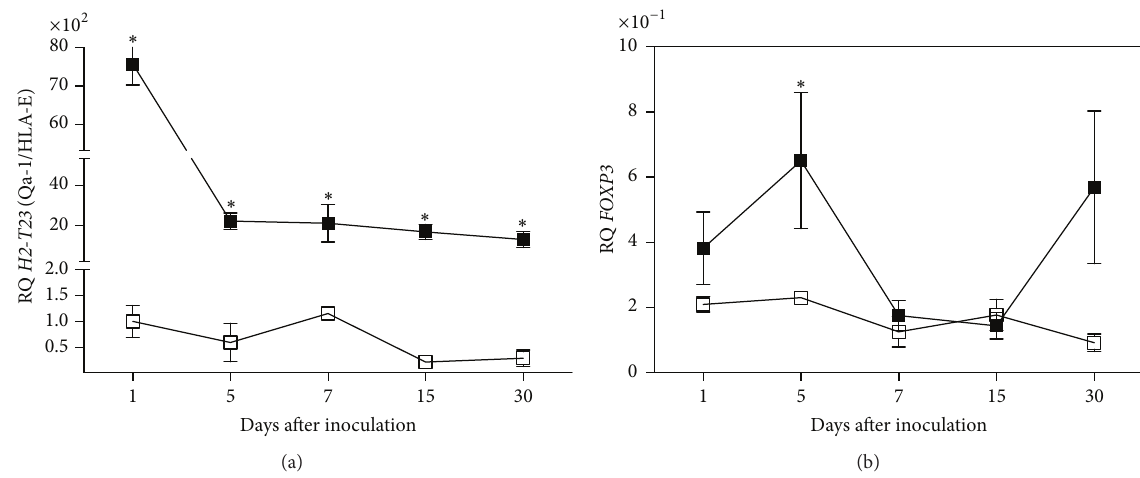
Figure 6: Comparison of transcriptional profiles of (a) H2-T23 (Qa-1/HLA-E) and (b) FOXP3 in thymus of C57BL/6 and BALB/c mice inoculated with 10.000 LD 50 of YFV17D. RQ = relative quantification representative of geometric mean values of 2 −ΔΔ Ct . RQ values expressed as fold change relative to control group values (baseline = 1). Statistical analysis was performed using the nonparametric test Mann-Whitney two-tailed. Values close to the level of significance ( 𝑃 < 0.05 ) are marked with ∗